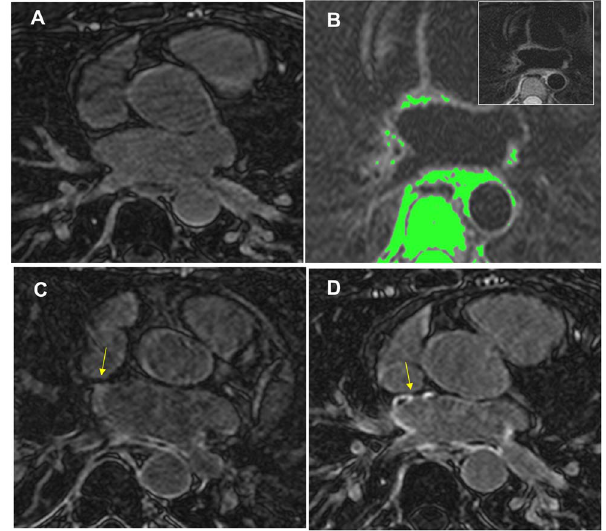
Figure 4. Axial CMR images demonstrating the progression of scar development of a single patient after PVI. A) Pre-PVI LGE